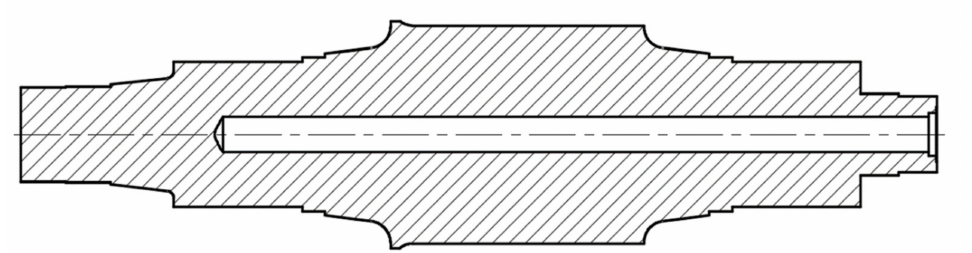
Figure 11. The section of optimization model of roller shaft.